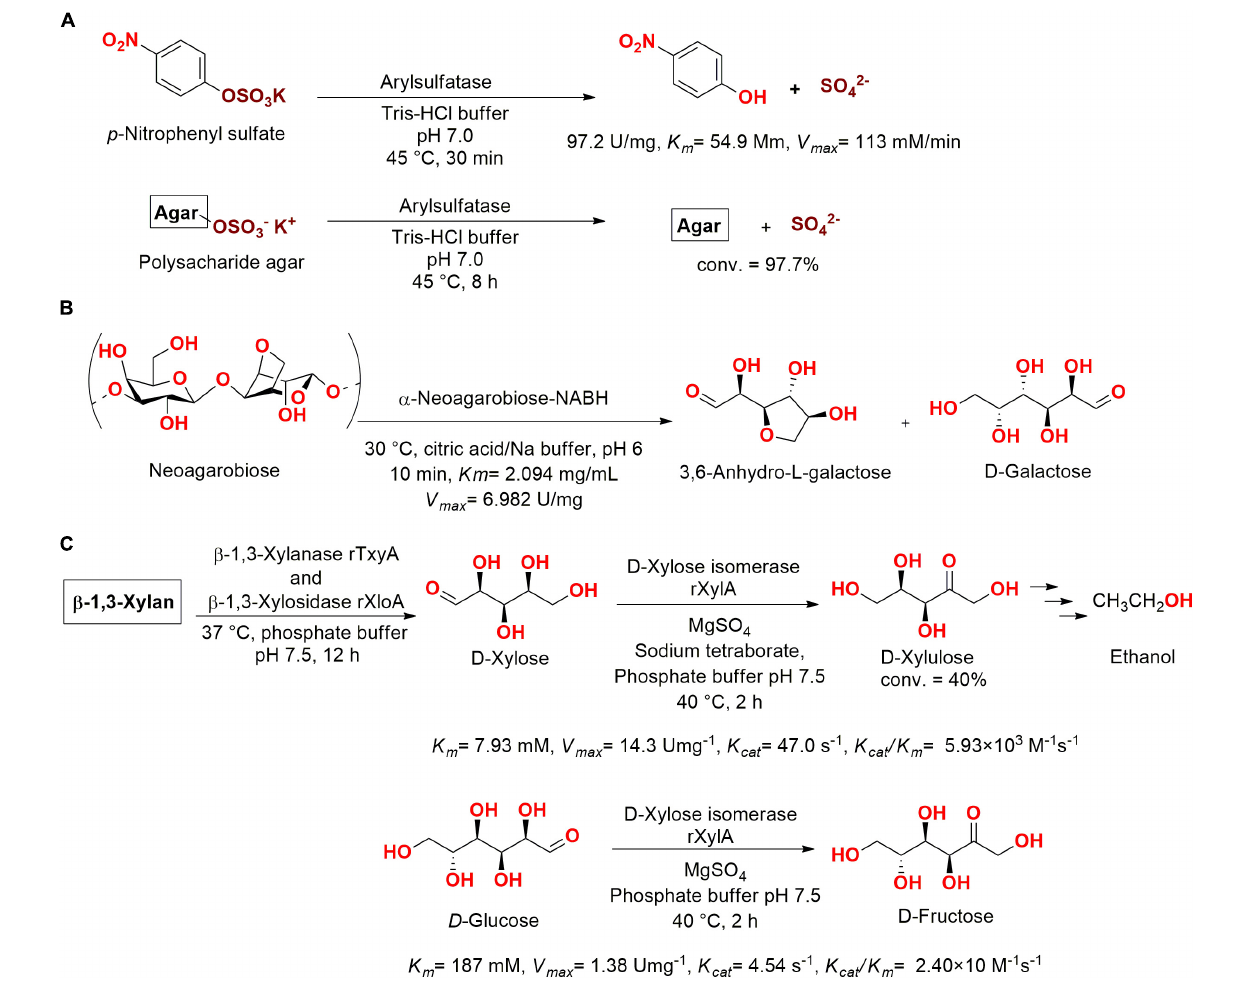
FIGURE 13 | (A) Hydrolysis of sulfate group using an arylsulfatase enzyme (Kim et al., 2004). (B) Hydrolysis of neoagarobiose into 3,6-anhydro- L -galactose and D -galactose (Liu et al., 2016). (C) D -xylulose production from β -1,3-xylan using employing the enzymes β -1,3-xylanase TxyA, β -1,3-xylosidase XloA, and D -xylose isomerase XylA from Vibrio sp. XY-214 (Umemoto et al.,